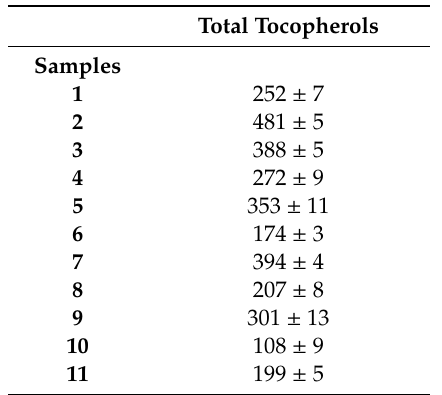
Table 5. Total tocopherol content (mg / kg oil) of commercial olive oil